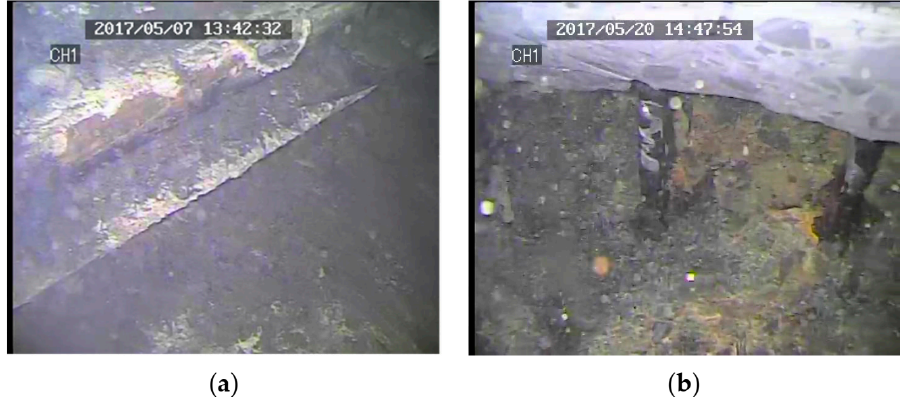
Figure 5. Pictures of the damaged condition of ( a ) joint area; ( b ) partial enlarged drawing.